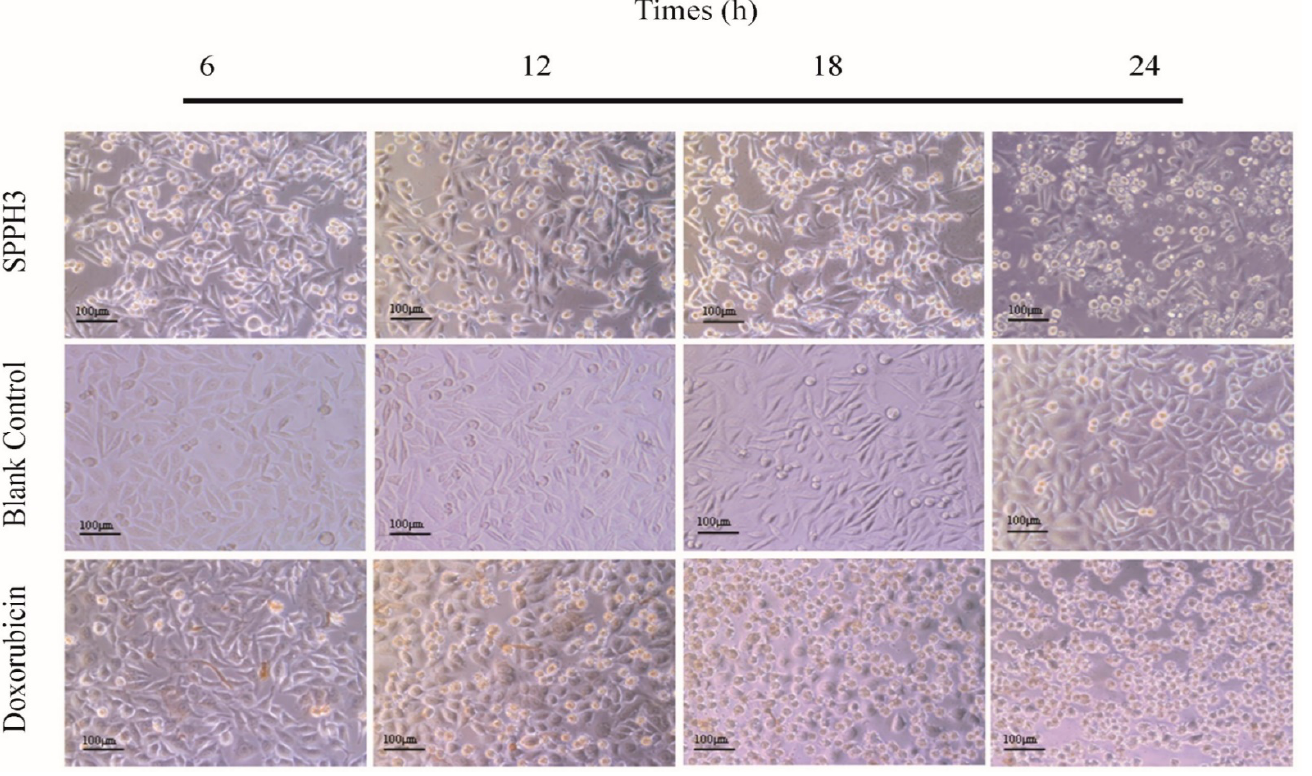
Figure 3. Cell morphology observed by an inverted microscope after treatment with SPPH3 and Doxorubicin at different times. MGC-803 cell proliferation inhibited by SPPH3 (0.31 mg/mL) was visualized; Doxorubicin (0.001 mg/mL) treatment was used as a positive control group. Normal cells were used as a blank control group. All of the cells were observed after 6, 12, 18 and 24 h treatments. The images were captured by a Leica inverted microscope at ×200 magnification. Scale bar = 100 μ m.